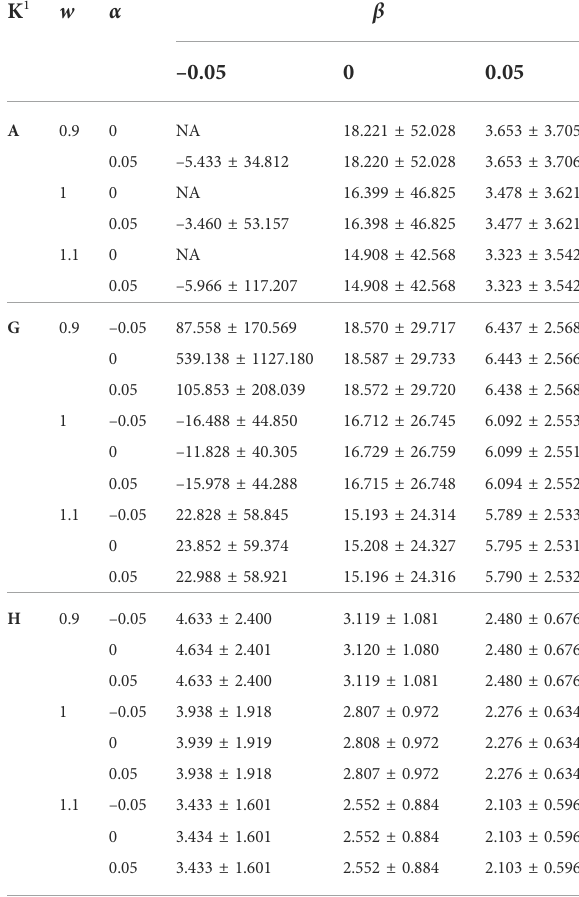
TABLE 1 The effect of w , α , and β ( w K + α 11 ′ + β I) on the distribution of diag(K − 1